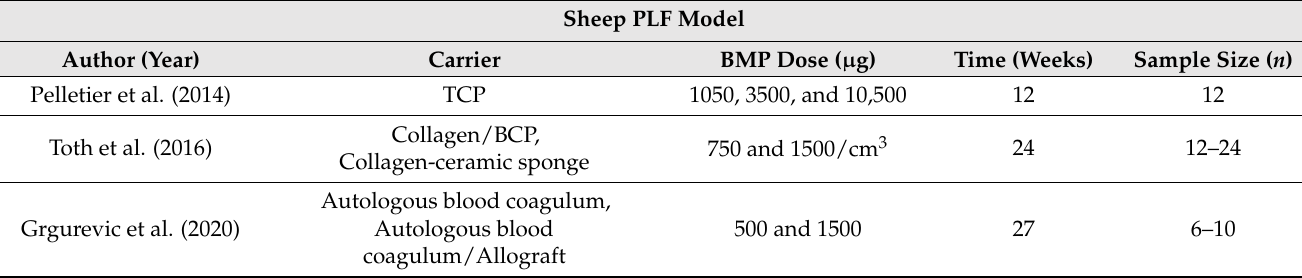
Table 6. Sheep and non-humane primate PLF